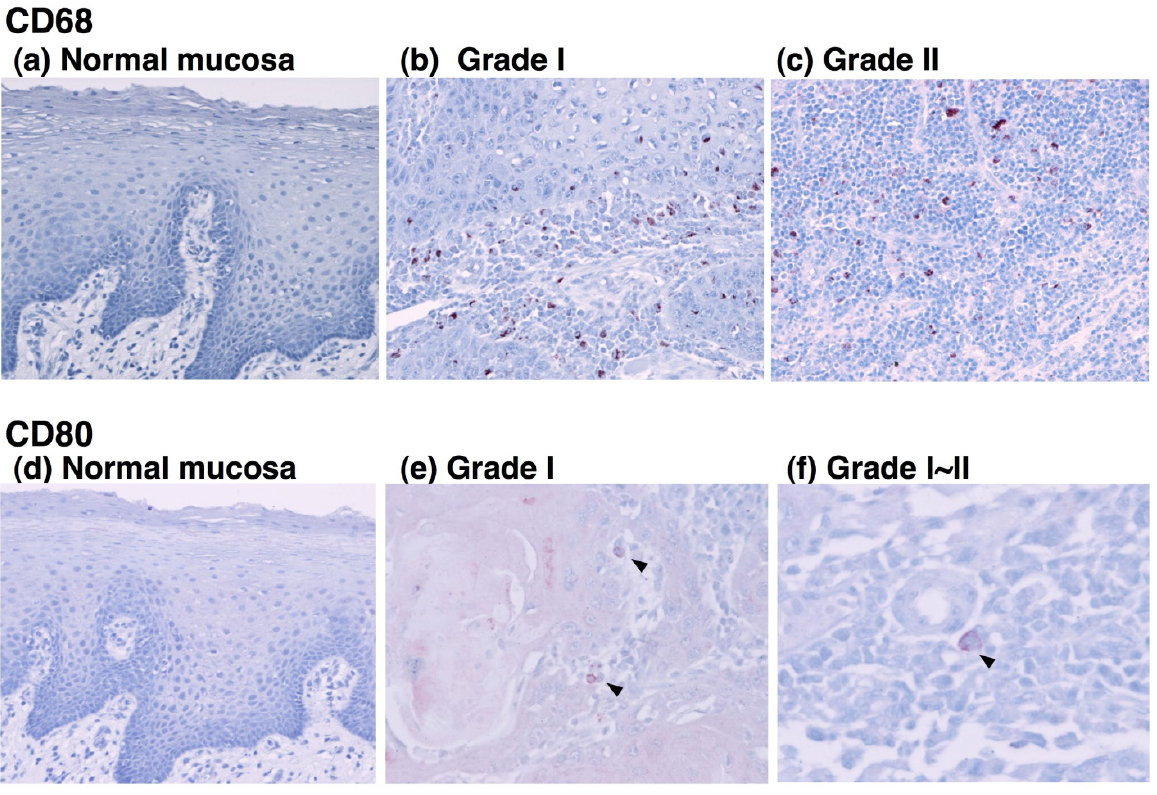
Figure 1. Immunohistochemical staining of OSCC with anti-CD68 and anti-CD80 antibodies. Immunoreactivity for anti-CD68 ( a-c ) and anti-CD80 ( d-f ) antibodies in normal oral mucosa ( a , d ; original magnification: 100×) and different pathological grades of OSCC ( b , c , e , original magnification: 200; f: 400×) are shown. No positive cells were observed in normal mucosa ( a , d ). CD68 + macrophages were distributed in the tumoral stroma and parenchyma even in the lower-grade tumors ( b ). CD80 + cells were sparsely distributed in the tumoral stroma (arrow heads; e , f